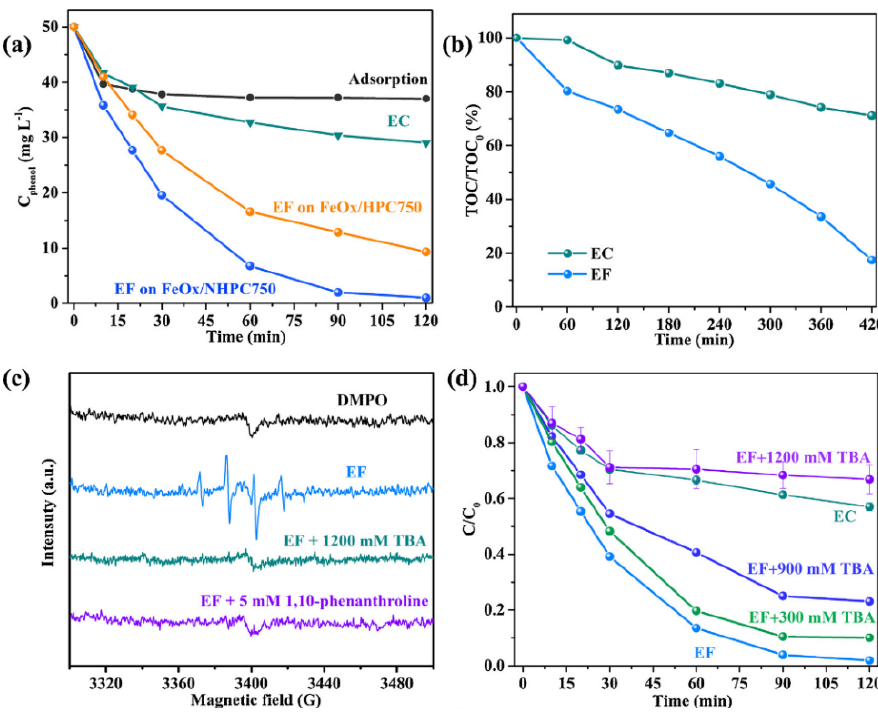
Figure 10. ( a ) Phenol removal curves of EC and hetero-EF on FeOx/NHPC750, as well as hetero-EF on FeOx/HPC750 at − 0.6 V; ( b ) TOC removal curves for EC and hetero-EF on FeOx/NHPC750; ( c ) DMPO spin-trapping spin resonance spectroscopy spectra during FeOx/NHPC750 EF process with 1500mM TBA or 5mM 1,10-phenanthroline; ( d ) effect of TBA concentration on hetero-EF degradation of phenol [76].